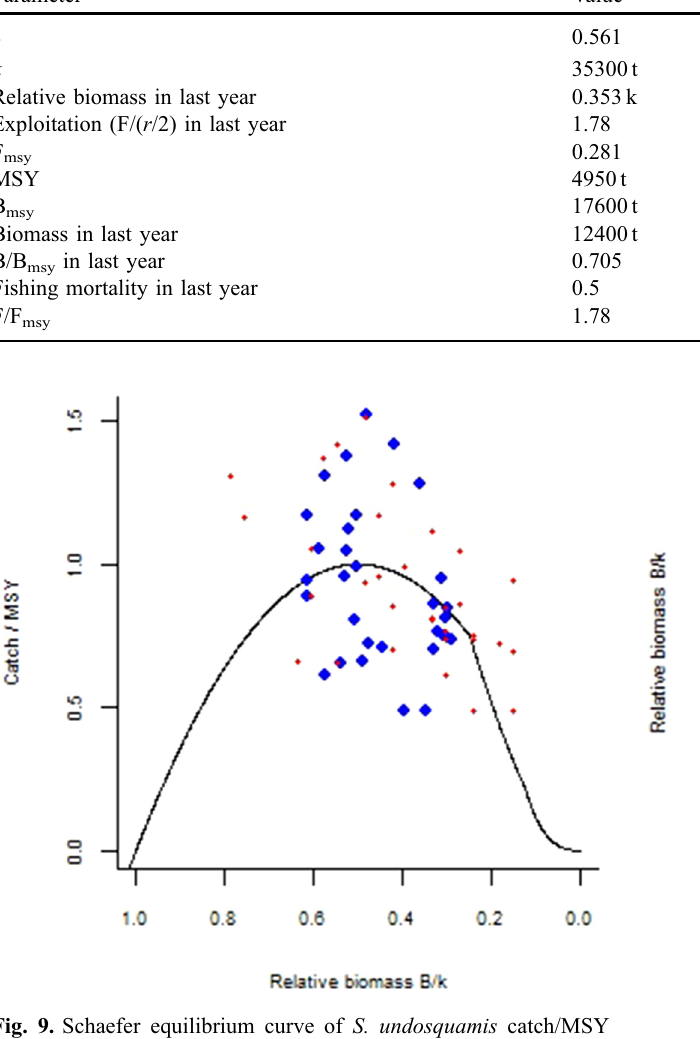
Fig. 10. CMSYpredictions of relative biomass B/ k (bold curve) with 2.5 th and 95 th percentiles (thin curves) compared to observed biomass (dashed curve) scaled by the respective BSM estimate for k , for S. undosquamis stock in southeastern Arabian